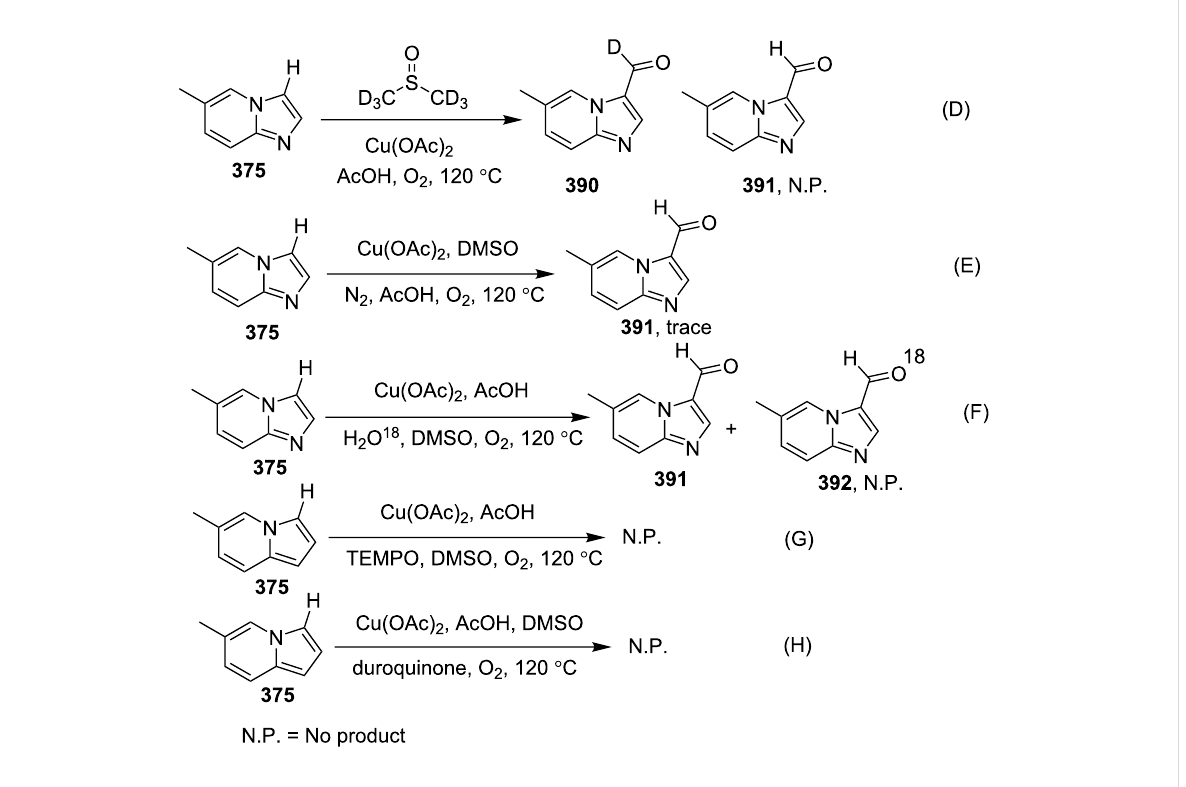
Scheme 131: Control experiments for signifying the role of DMSO and